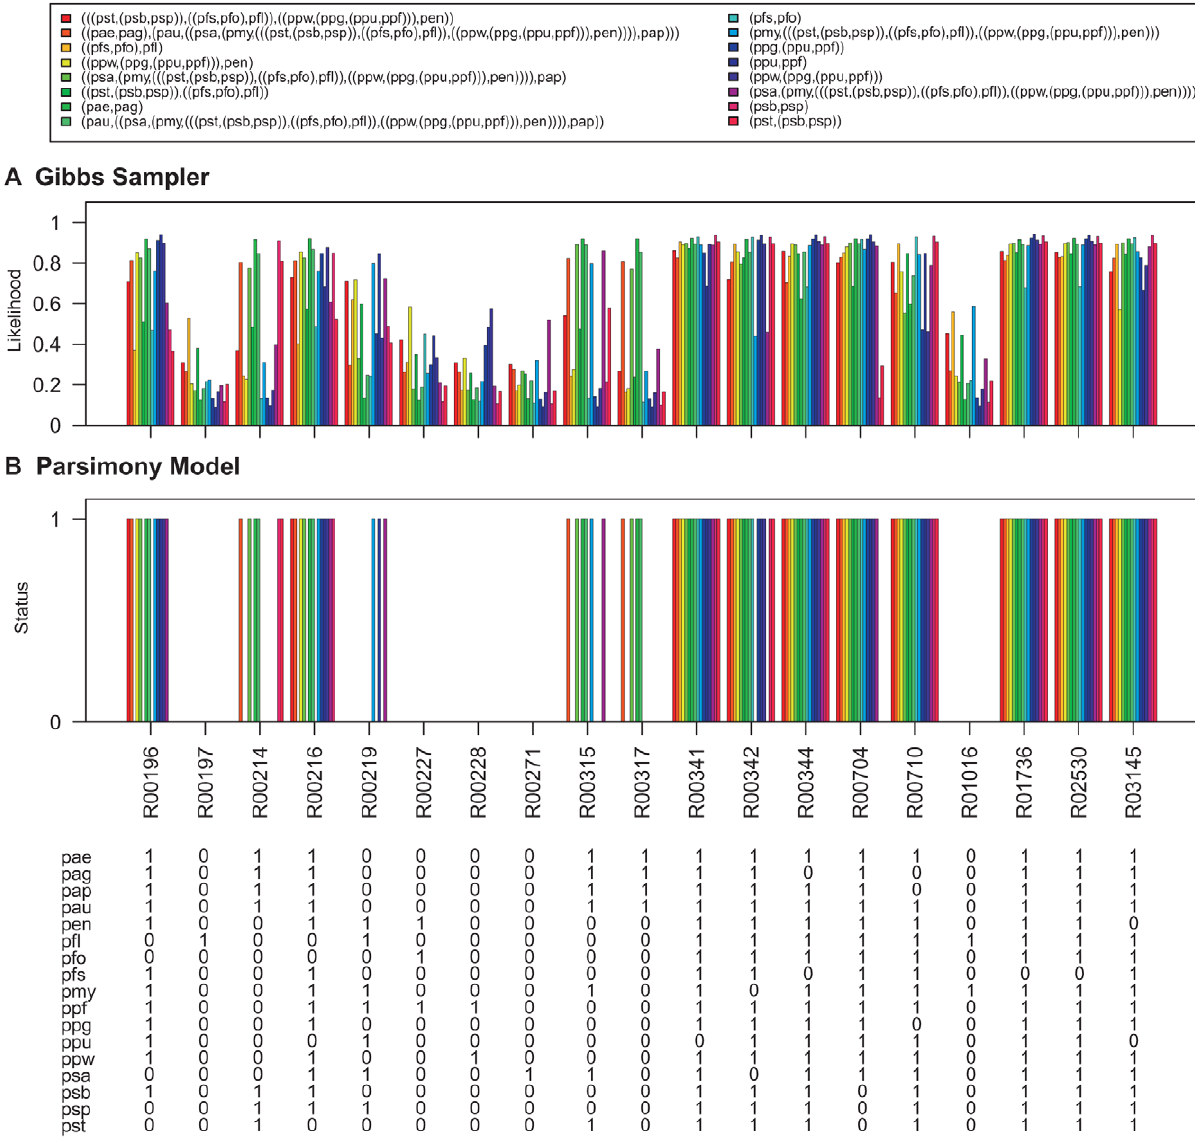
Figure 12. Ancestral network reconstruction for the pyruvate metabolism map. The ancestral networks were reconstructed over the Pseudomonas phylogeny shown in Figure 6A. Also shown in the bottom panel is the distribution of reactions across different Pseudomonas strains. (A) Likelihood of being present for alterable reactions at various levels of Pseudomonas phylogeny obtained by calculating the proportion of times each hyperedge was present in the networks sampled by the Gibbs sampler. (B) Reaction status obtained under maximum parsimony calculated using the Fitch algorithm [26]. When assigning the reactions at the ancestral nodes the ties were resolved in favor of presence of reactions. Strain abbreviations: pae: P. aeruginosa PAO1, pap: P. aeruginosa PA7, pau: P. aeruginosa PA14, pag: P. aeruginosa LESB58, pen: P. entomophila L48, pfl: P. fluorescens Pf-5, pfo: P. fluorescens Pf0-1, pfs: P. fluorescens SBW25, pmy: P. mendocina ymp, ppf: P. putida F1, ppg: P. putida GB-1 ppu: P. putida KT2440, ppw: P. putida W619, psa: P. stutzeri A1501, psb: P. syringae pv. syringae B728a, psp: P. syringae pv. phaseolicola 1448A, and pst: P. syringae pv. tomato